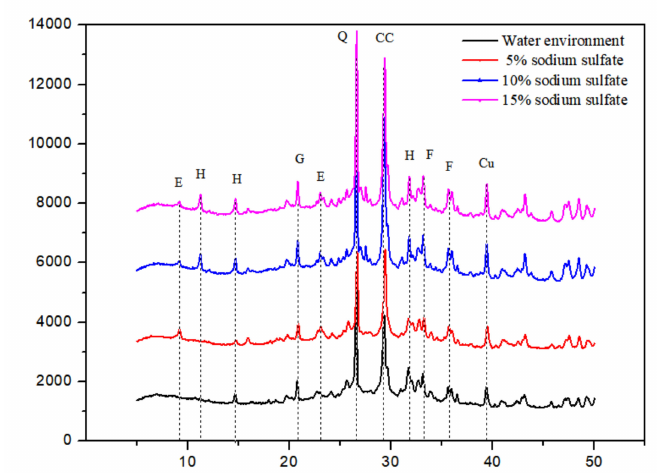
Figure 6. XRD patterns under a 75% high-sulphur fly ash content. E: Ettringite; H: Calcium sulphate hemihydrate; G: Gypsum; Q: Quartz; CC: Calcite.